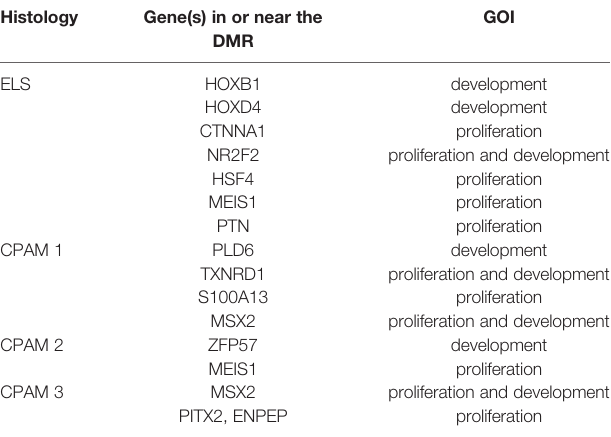
TABLE 3 | GOI close to signi fi cant DMRs repeated at least three times when each malformed sample was compared to the controls. Patient